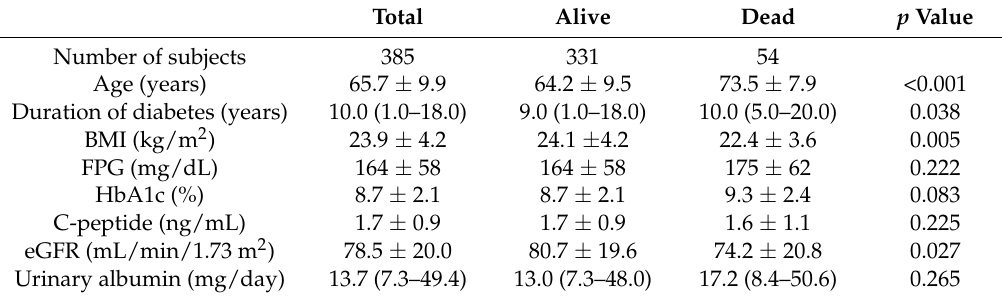
Table 1. Baseline characteristics of subjects and comparison of demographic and biochemical parameters between dead patients and